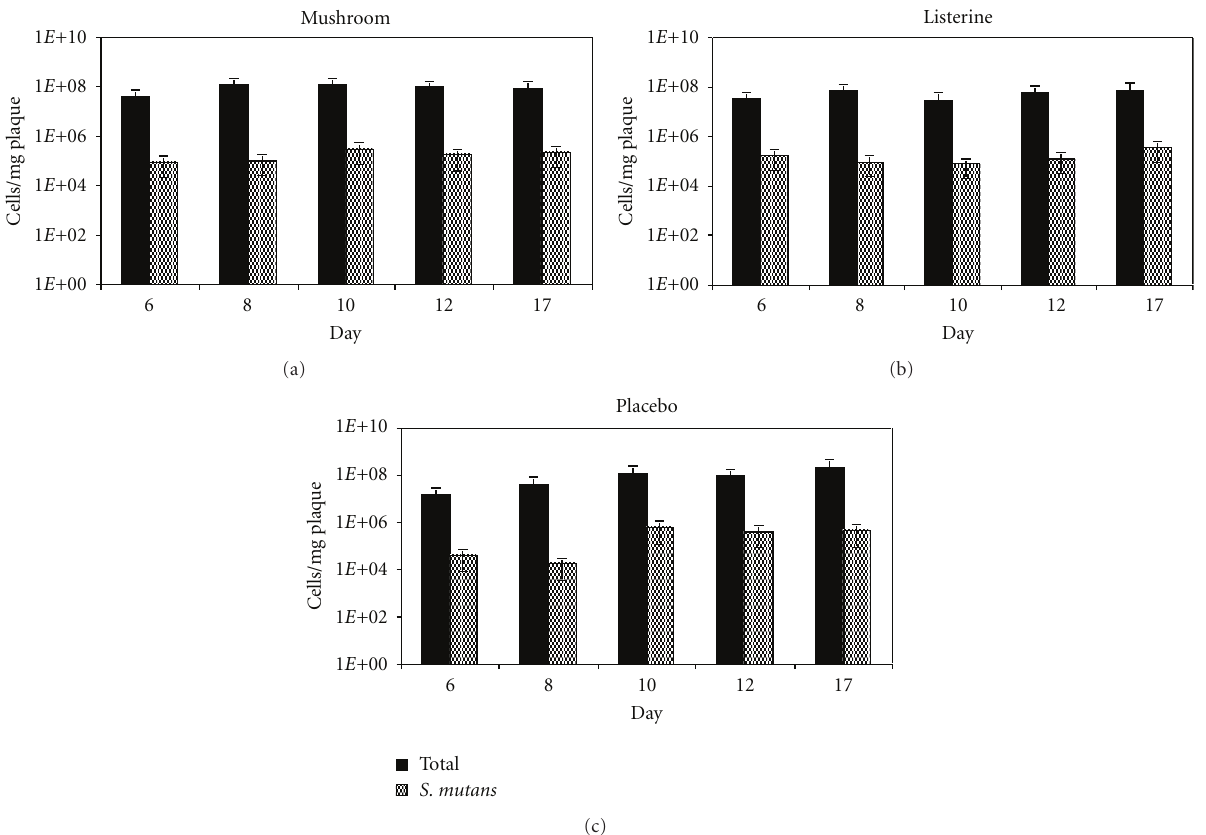
Figure 3: Numbers of S. mutans and total counts in dental plaque samples of the three cohorts enrolled in the study. Standard error bars represent the standard deviation ( n =